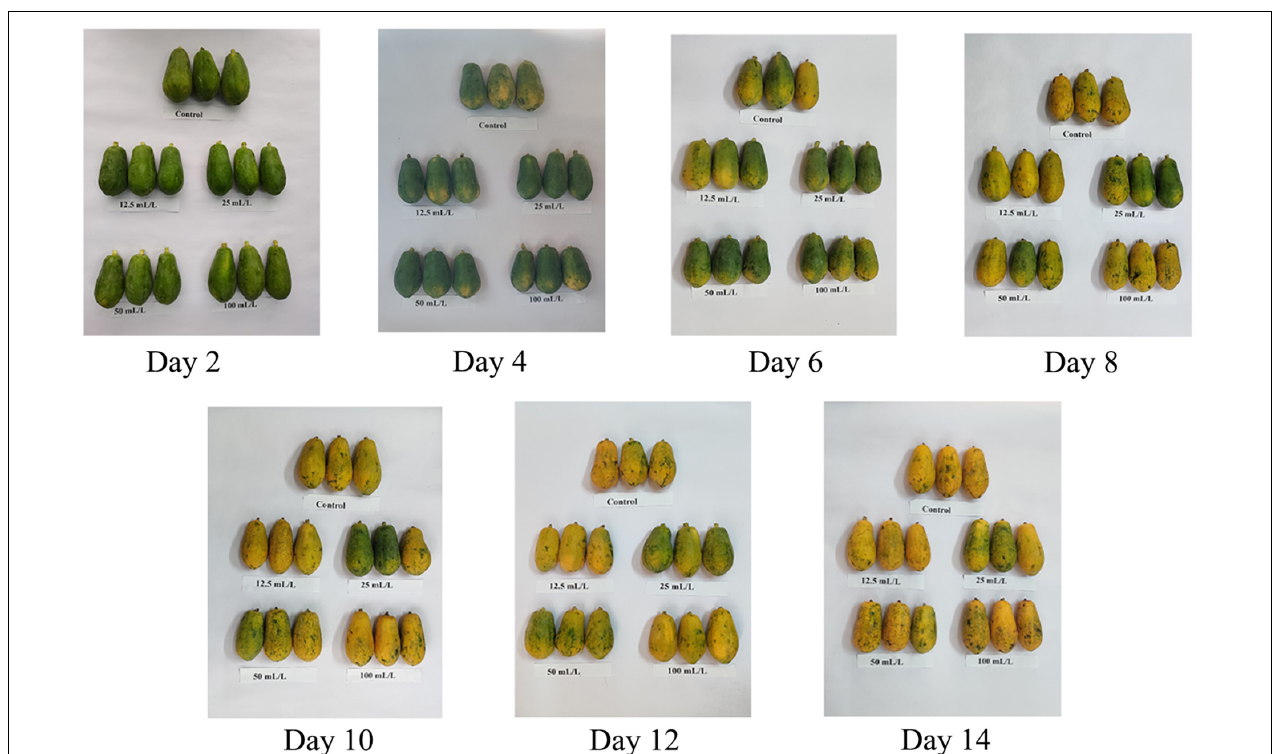
FIGURE 1 | Color-changing of papaya fruits treated with 0, 12.5, 25, 50, and 100 mL/L ethanol within 14